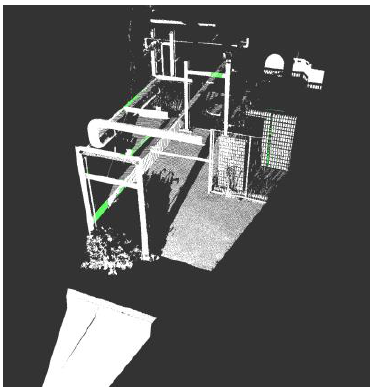
Figure 3. Result of cluster grouping. White points indicate “measured” and green points indicate